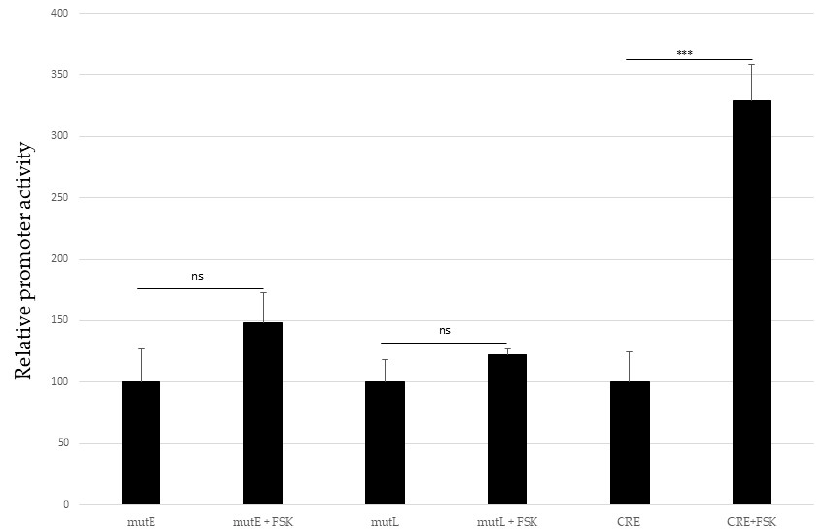
Figure 9. Activation of the PKA pathway does not induce the MCPyV early and late promoter. HaCaT cells were transfected with a luciferase reporter plasmid containing either the MCPyV early or late promoter, or a minimal promoter with four copies of the cAMP response element